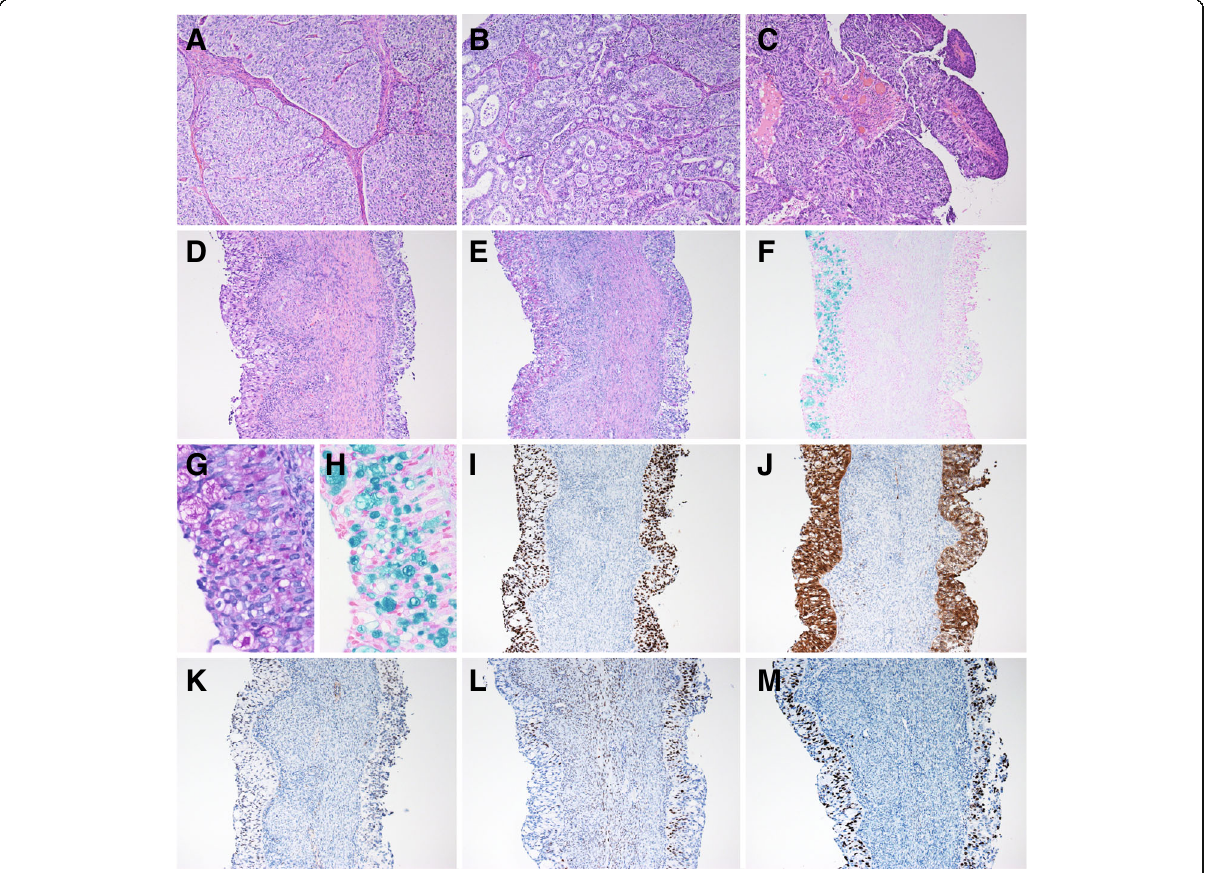
Fig. 2 Pathological findings of the ovarian cancer. a − d the cancer cells show various morphology, including solid ( a ), pseudo-endometrioid ( b ) transitional-like ( c ) and mucin-producing ( d ) patterns. e − h Representative PAS ( e , g ) and Alcian blue ( f , h ) stained images of mucin-producing cancer cells. Note that ratio of mucin-producing tumor cells is different between the right and left side of septa. i − m Representative immunostained images of the p53 ( i ), p16 ( j ), WT1 ( k ), PgR (L) and Ki-67 ( m